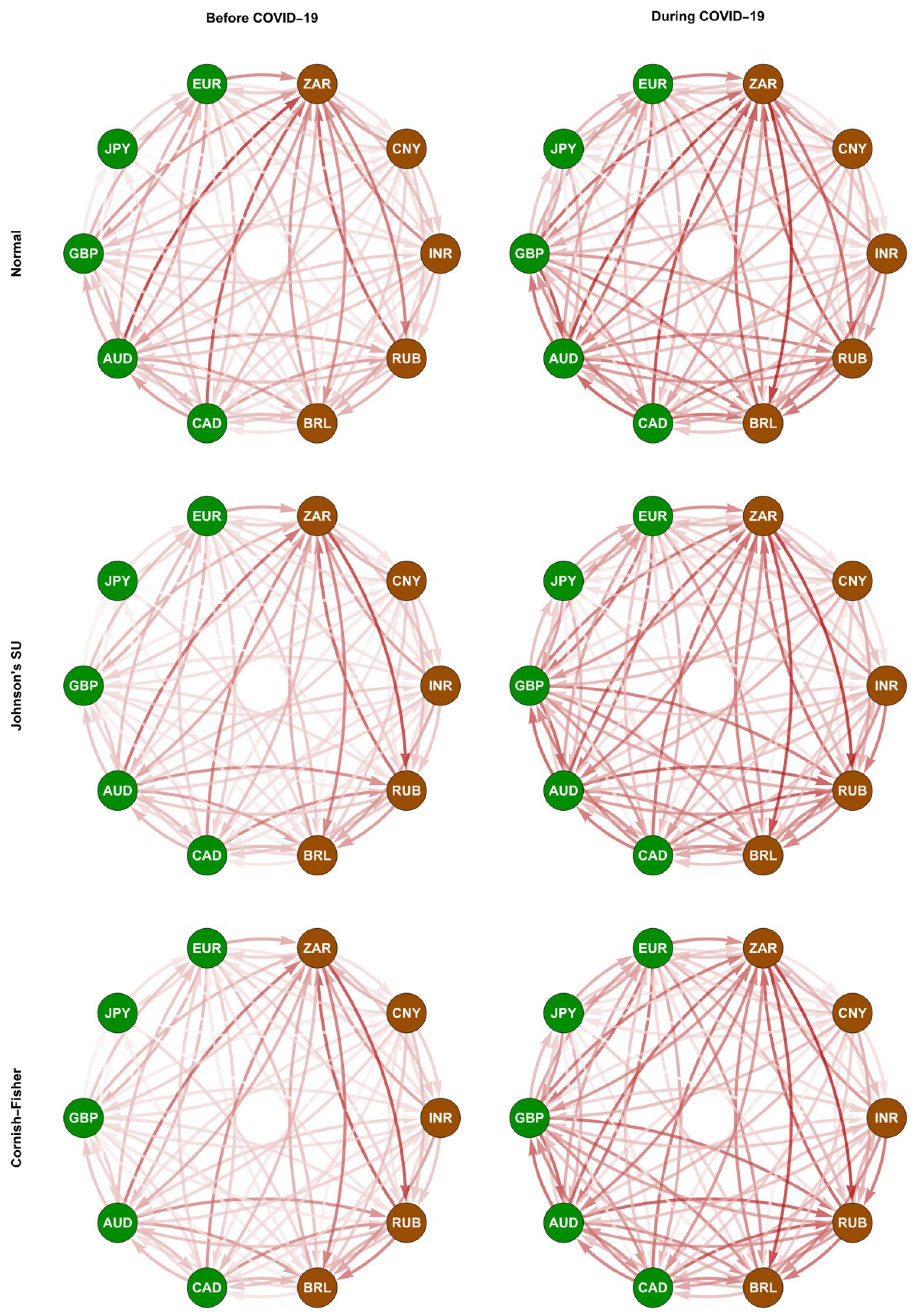
Fig 6. Conditional tail risk networks based on Δ CoVaR forecasts. The green and brown nodes represent the advanced and emerging forex markets, respectively. The darkness of each edge indicates the magnitude of its weight, as we present in Fig